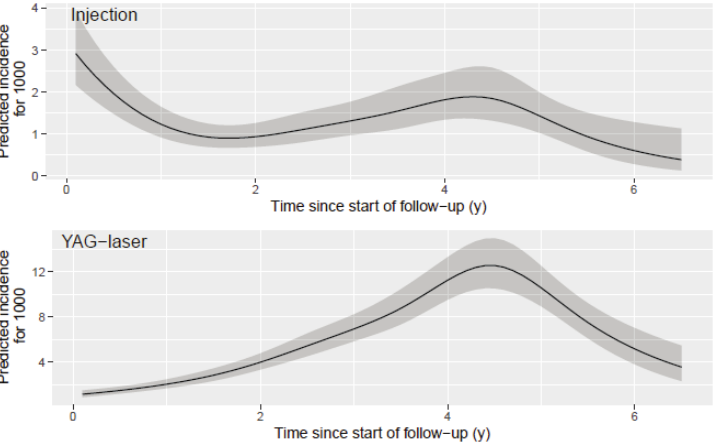
Figure 2. Predicted incidence with 95% confidence interval for intravitreal anti-VEGF injection and Nd:YAG-laser capsulotomy based on Poisson regression